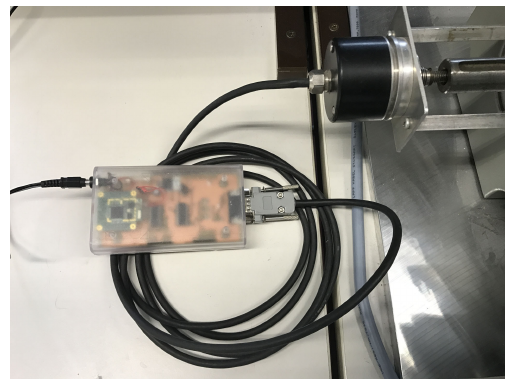
Figure 7. Hardware of the rotor speed